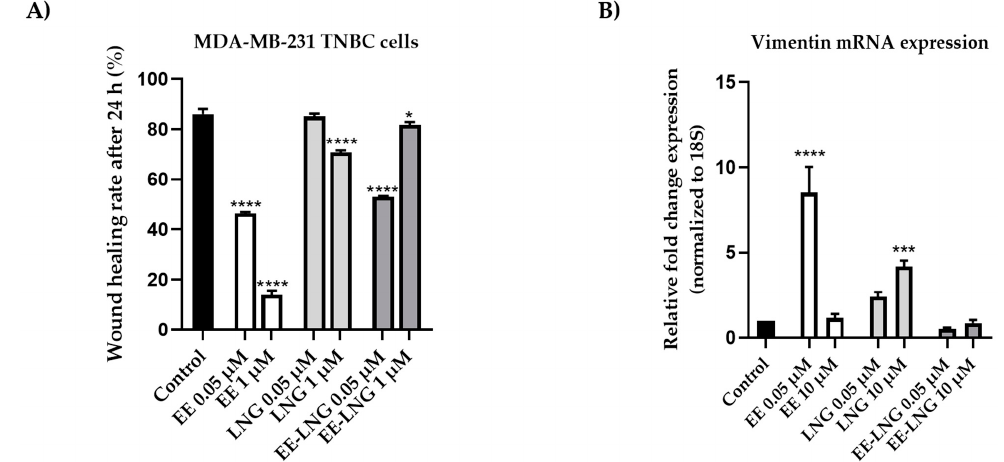
Figure 4. ( A ) The impact of EE, LNG, and EE-LNG 0.05 and 1 µM on the migratory capacity of the MDA-MB-231 breast cancer cell line by applying the wound healing assay. The bar graphs are expressed as percentage of wound closure after 24 h compared to the initial surface. ( B ) The influence of EE, LNG, and EE-LNG (0.05 and 1 µM) on the Vimentin mRNA expression was recorded after a 48 h treatment. The data are presented as relative fold change expression normalized to 18S (used as housekeeping gene). All results are expressed as mean values ± SD of three independent experiments performed in triplicate. The statistical differences between the control and the treated group were identified by applying the one-way ANOVA analysis, followed by the Dunnett’s multiple comparisons post-test (* p < 0.05, *** p < 0.001, and **** p < 0.0001).